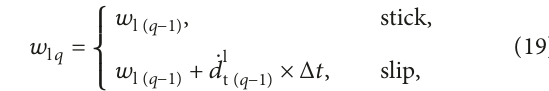
and d r are the n n